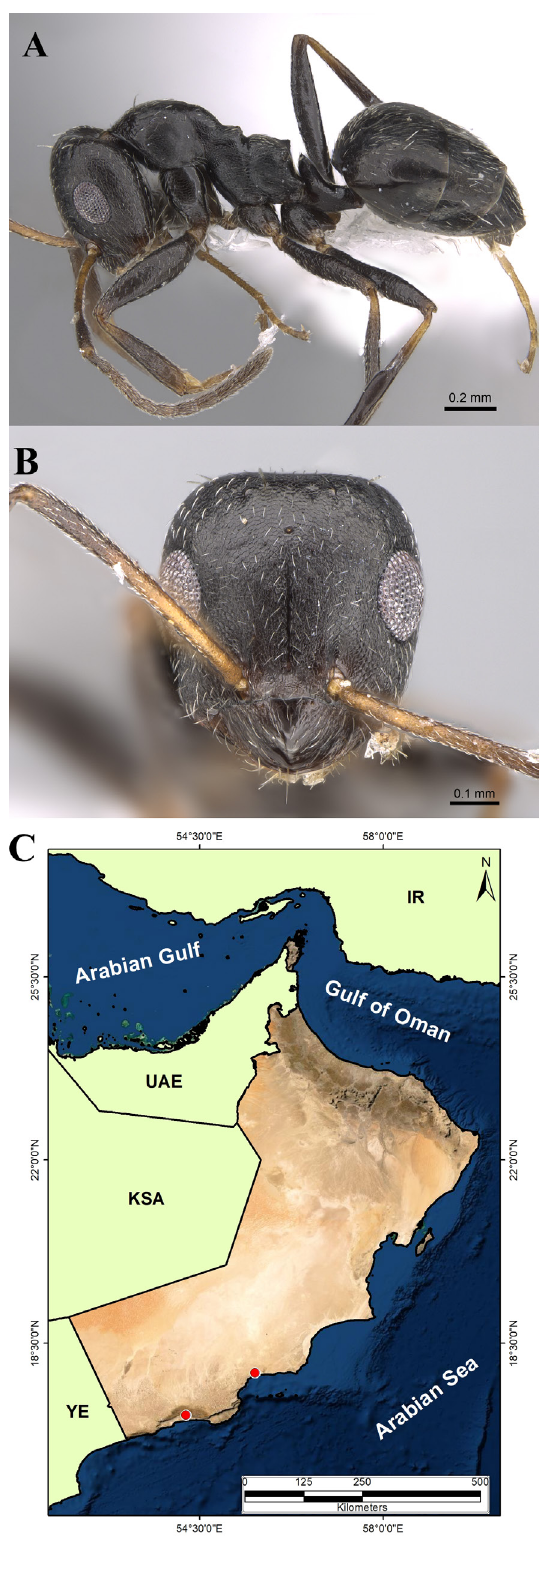
Fig. 16. Lepisiota carbonaria (Emery, 1892), worker (CASENT0922845, AntWeb.org (Michele Esposito)). A . Body in profile. B . Head in full-face view. C . Distribution